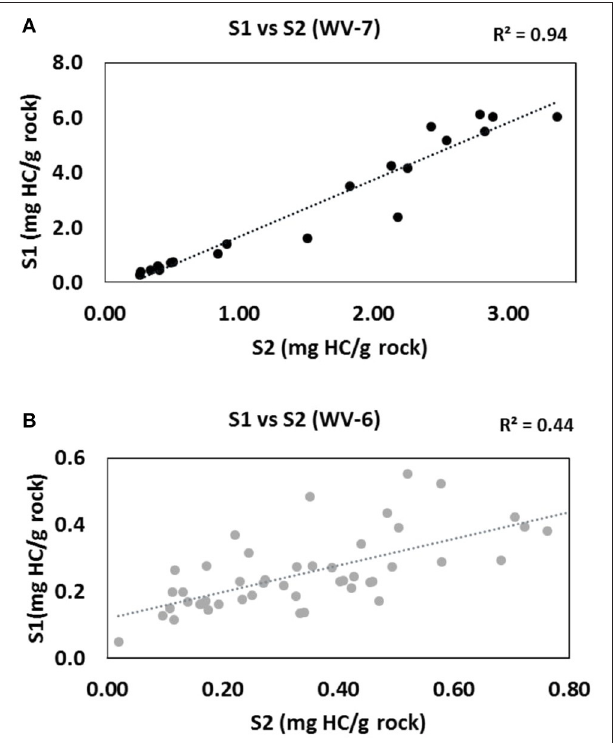
FIGURE 6 | The S2/S3 vs. TOC plots for (A) WV-6 and (B) WV-7 samples. (0.54) values for WV-6 samples as compared to WV-7 samples ( R 2 = 0.92) also provide evidence that WV-6 samples received mixed sources of OM during